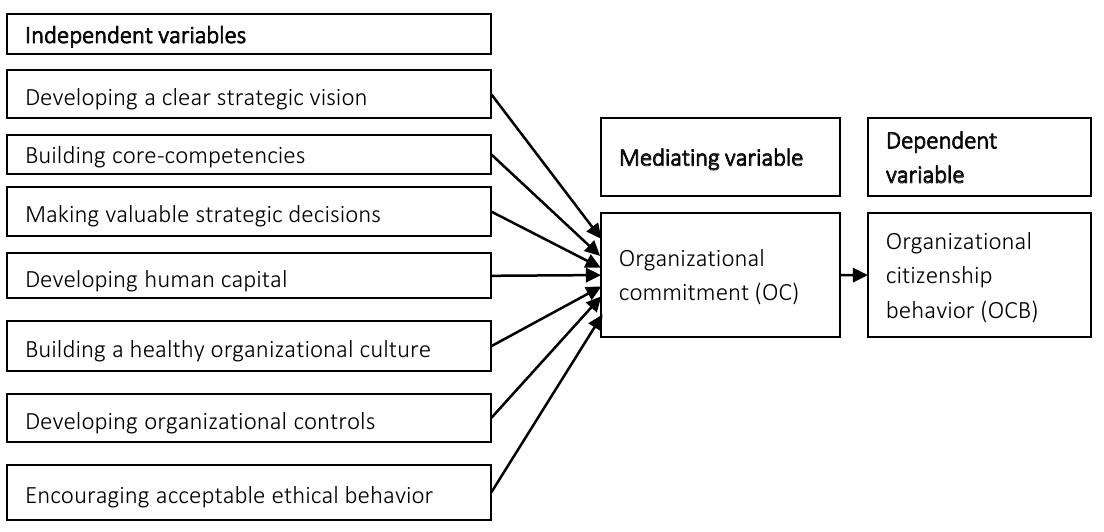
Figure 1. Conceptual